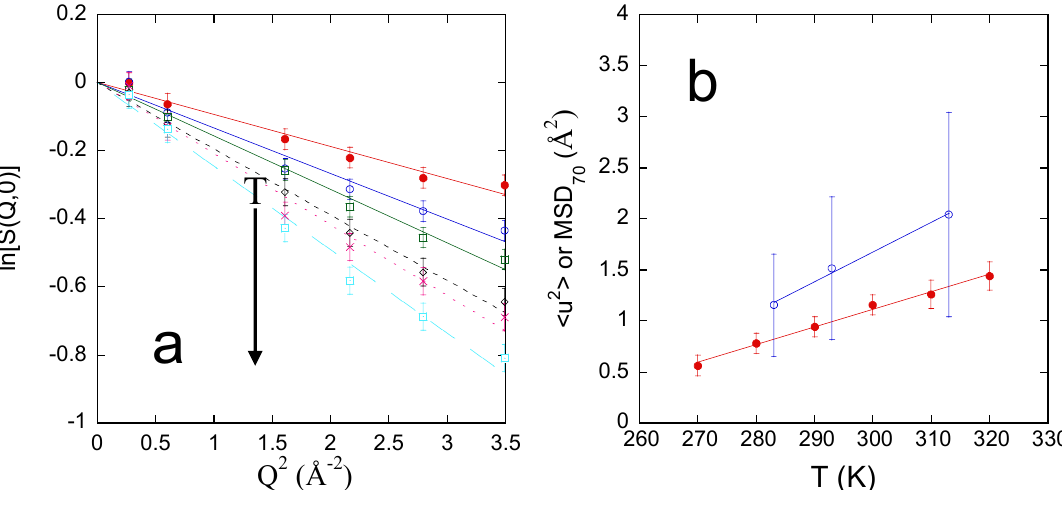
Figure 10. (a) Low Q behavior of the elastic scattering law at 270, 280, 290, 300, 310 and 320 K, the arrow indicating increasing temperatures. (b) Mean squared displacement of polymer hydrogen atoms by ENS experiments (red symbols) and system average of the mean squared displacement of backbone carbon atoms by MD simulations (blue